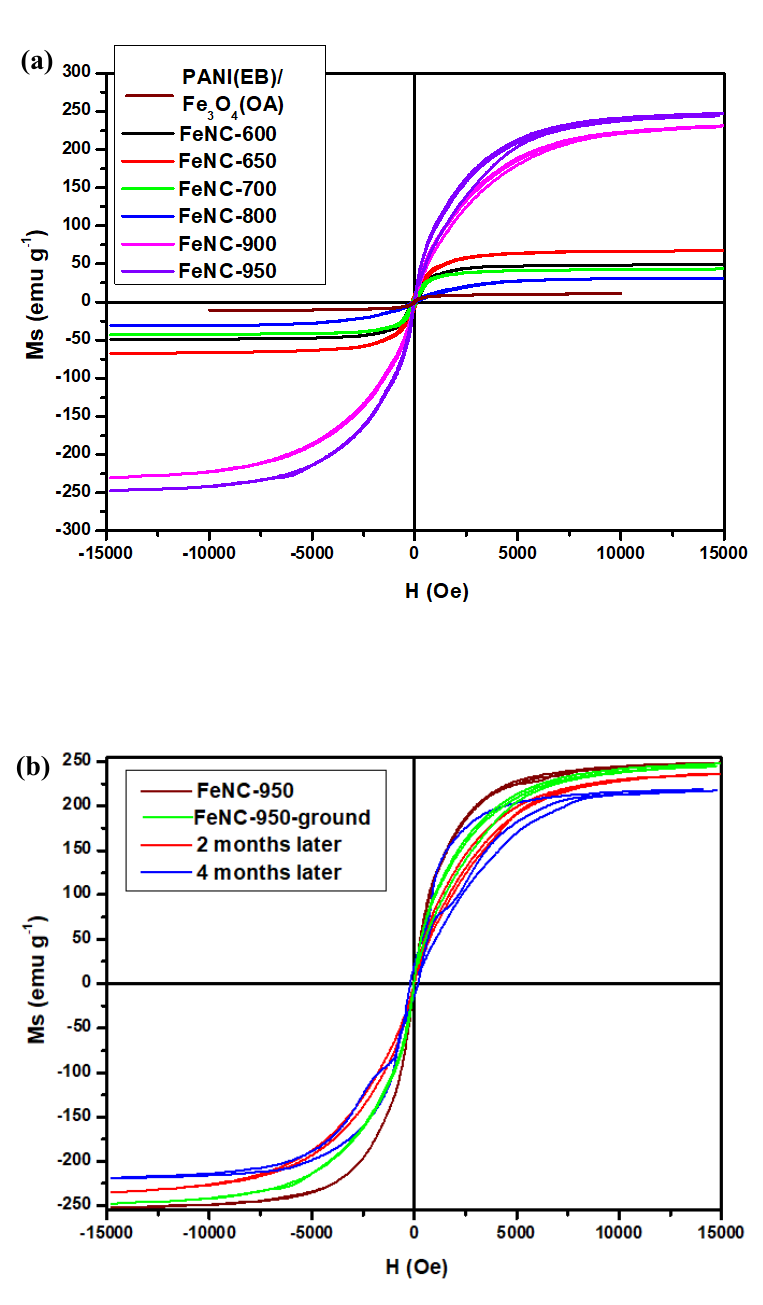
Figure 10. Saturated magnetization of ( a ) FeNCs and ( b ) various FeNC-950.